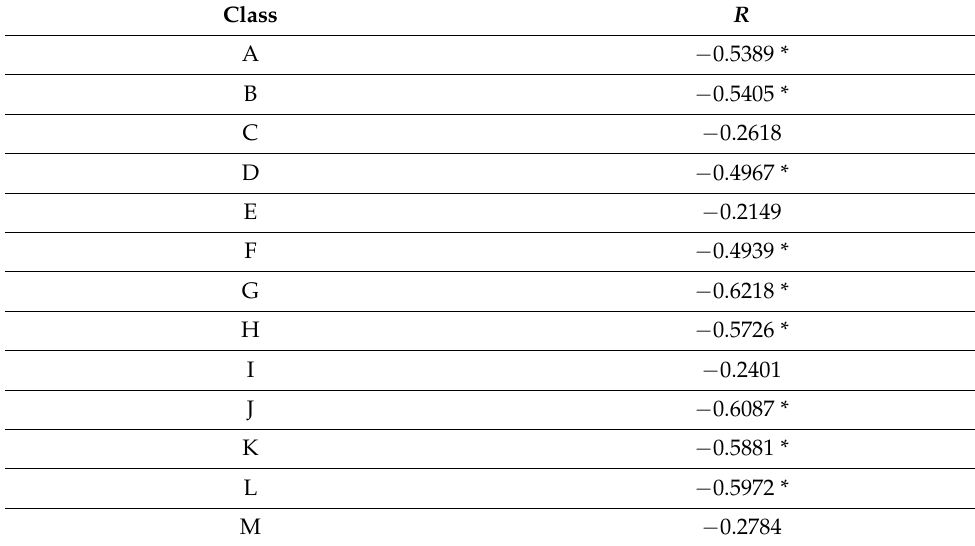
Table 1. Spearman’s rank correlation coefficient between students’ scores in KHT and scores in intelligence tests in individual classes.